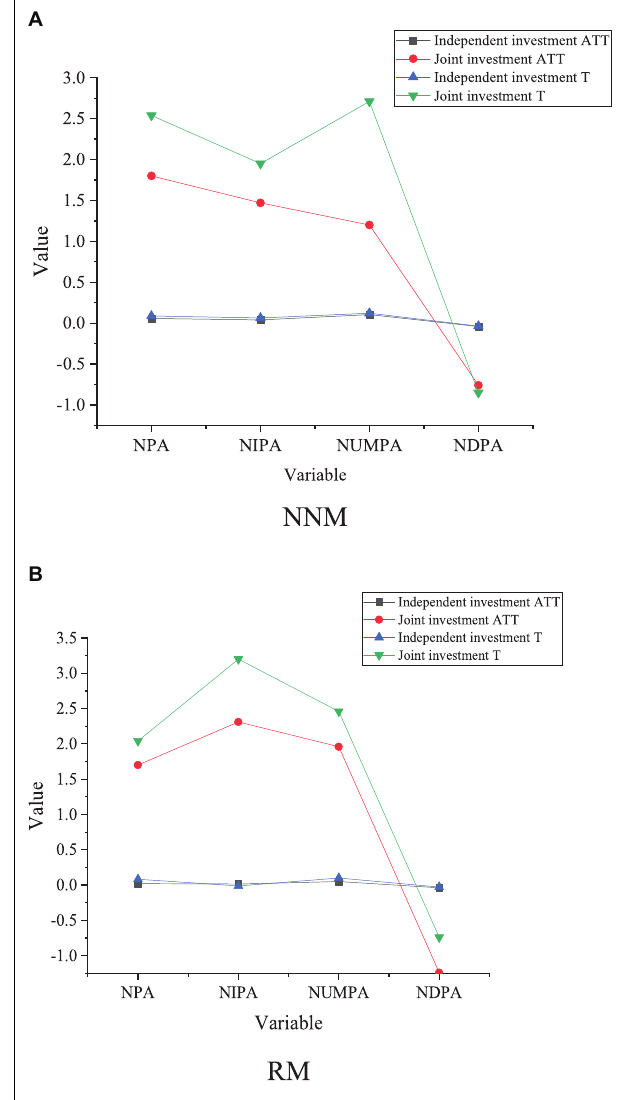
FIGURE 7 | Impact of venture capital with the same strategy on startups performance. (A) NNM. (B)